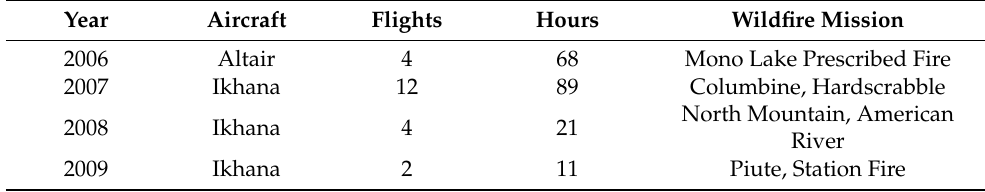
Table 4. Ikhana (and its predecessor, Altair) during the 2006–2009 fire seasons [121].